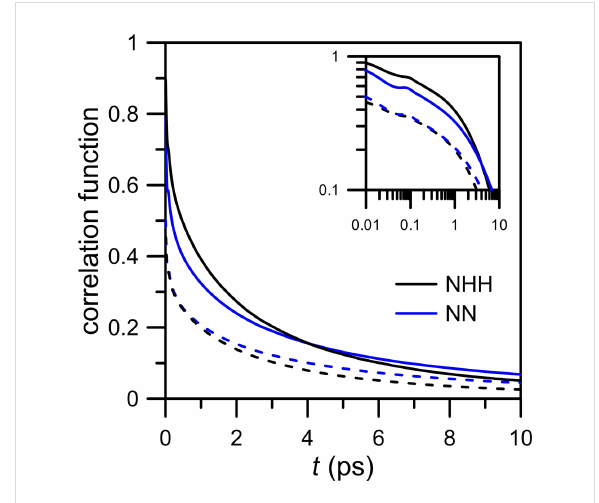
Figure 14: Hydrogen-bond correlation functions for hydrogen bridges between water and nitrogen atoms located in the nanopore rims calcu- lated for separation systems containing 200 water molecules. The inset panel shows the log–log plot of the same data. The solid lines are autocorrelation functions corresponding to water–nitrogen pairs be- tween which at least one hydrogen bond was made during simulations, whereas the dashed lines are AC functions calculated using all possible water–nitrogen pairs, i.e., even those between which there was no hydrogen